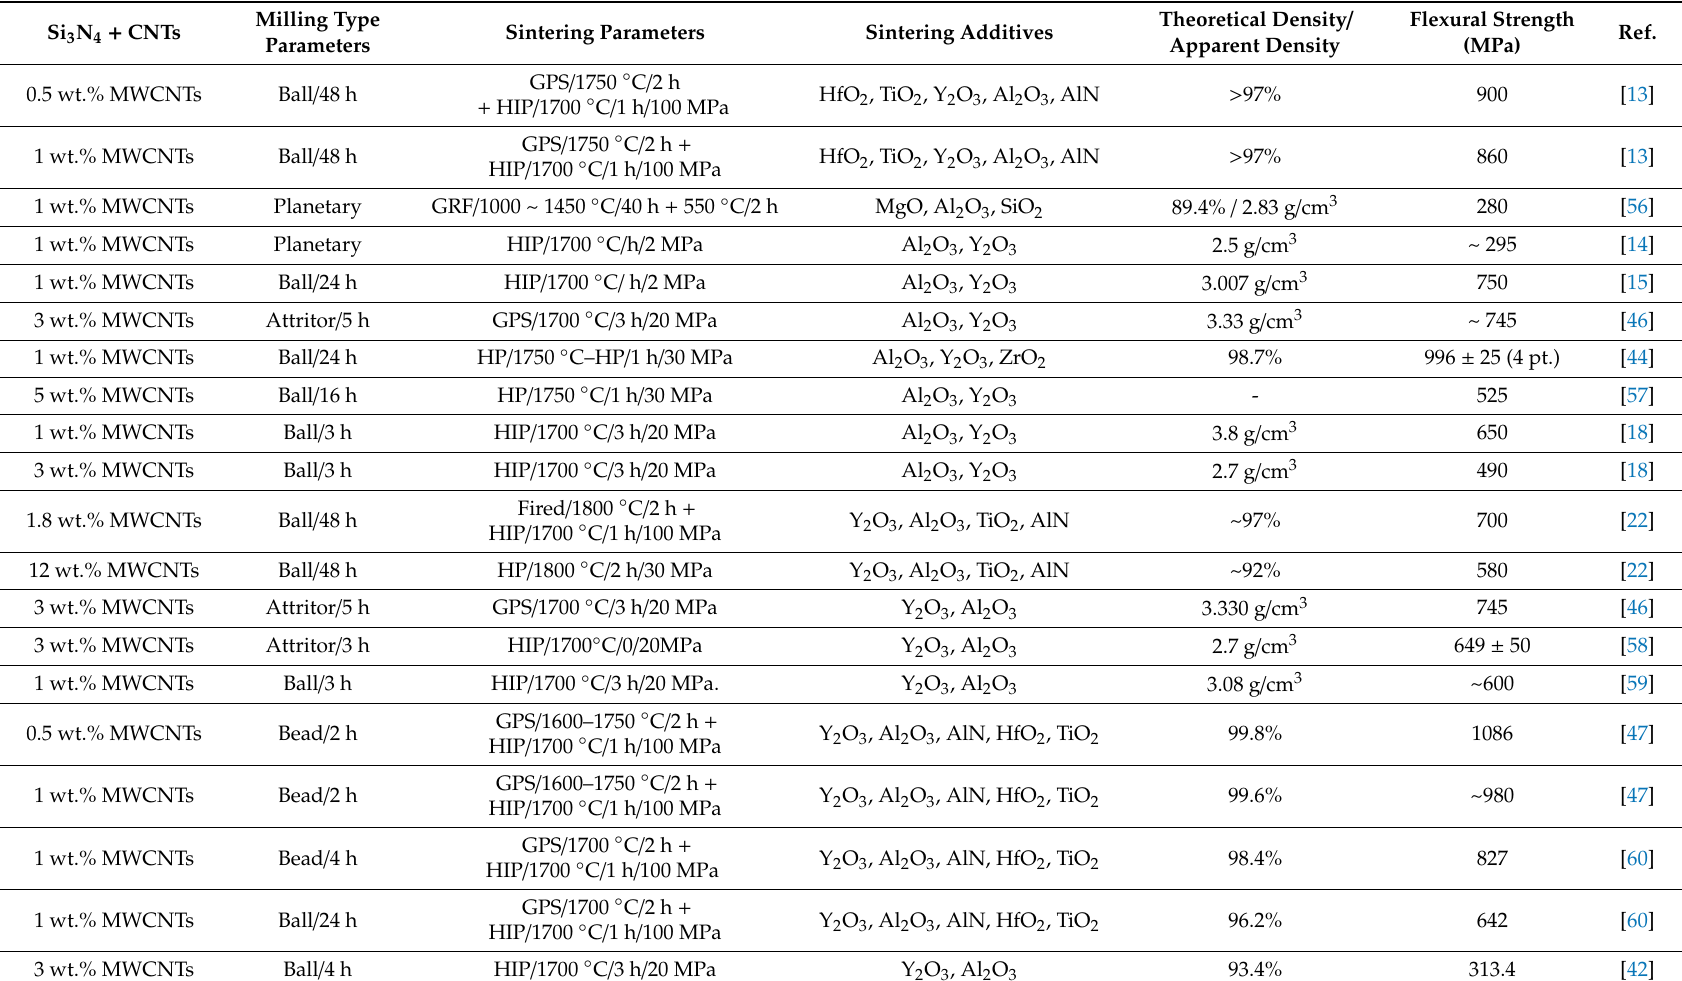
Table 3. Flexural strength of Si 3 N 4 + CNT composites prepared by di ff erent processing